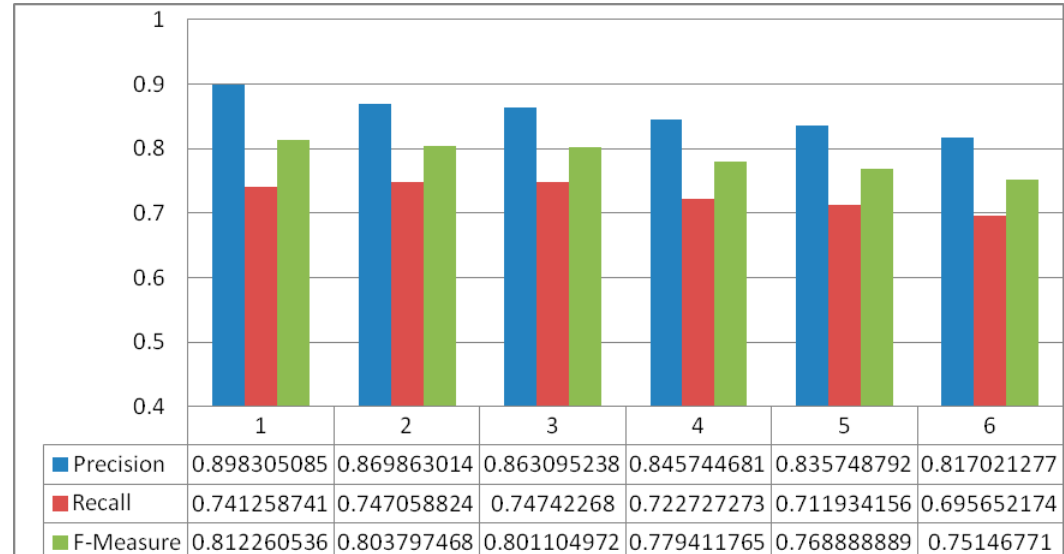
Figure 9. DDSS results in terms of precision, recall, and f-measure of match making process for 6 different experiments. Sensors 2016 , 16 , 531